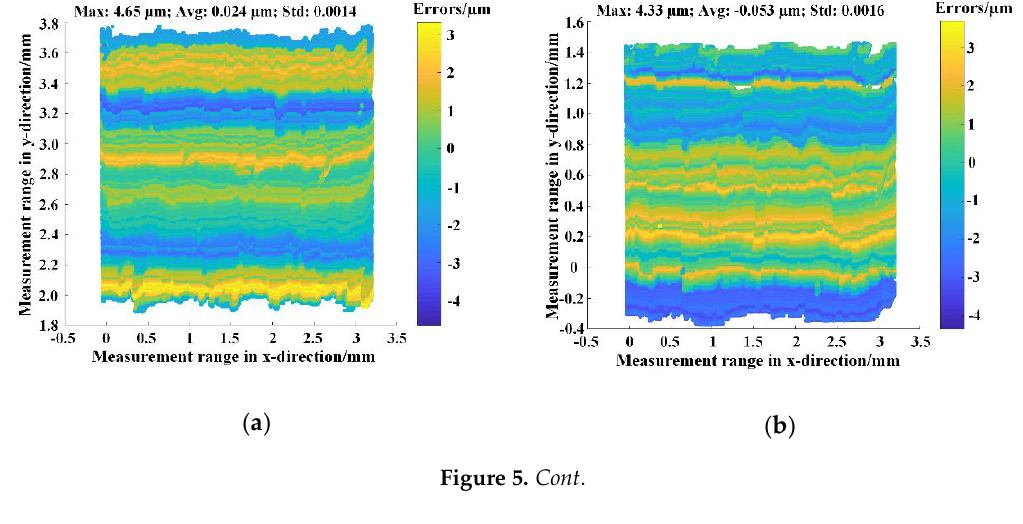
Figure 5 . Cont. Figure 5. Cont